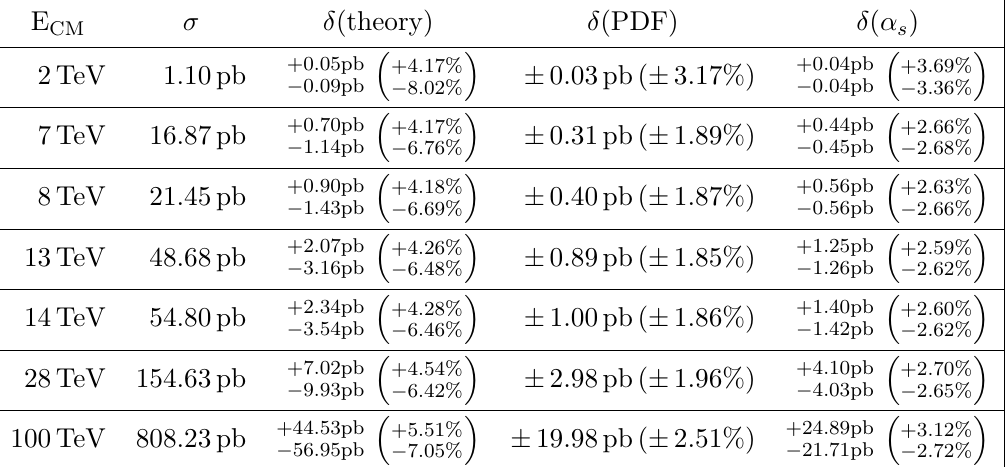
Table 1 . Cross sections and uncertainties as function of the collider center of mass